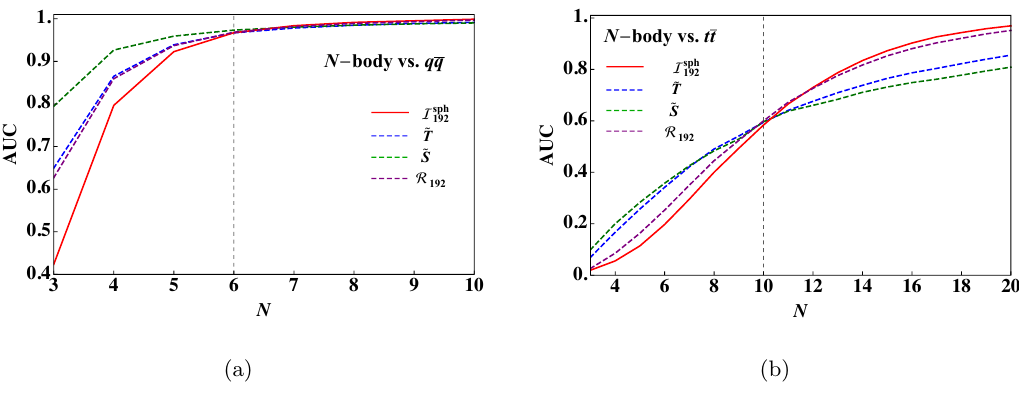
Figure 11 . The AUC values as a function of N for discriminating uniform N -body samples from (a) q (cid:22) q events and (b) t (cid:22) t events. Shown are event isotropy, thrust, sphericity, and the ratio observable p as computed for e + e (cid:0) collisions at s = 350 GeV. The crossover where event isotropy outperforms the other observables occurs after N = 6 for the q (cid:22) q sample and after N = 10 for the t (cid:22) t sample. AUC values less than 0.5 indicate when the N -body sample is less isotropic than the SM sample.